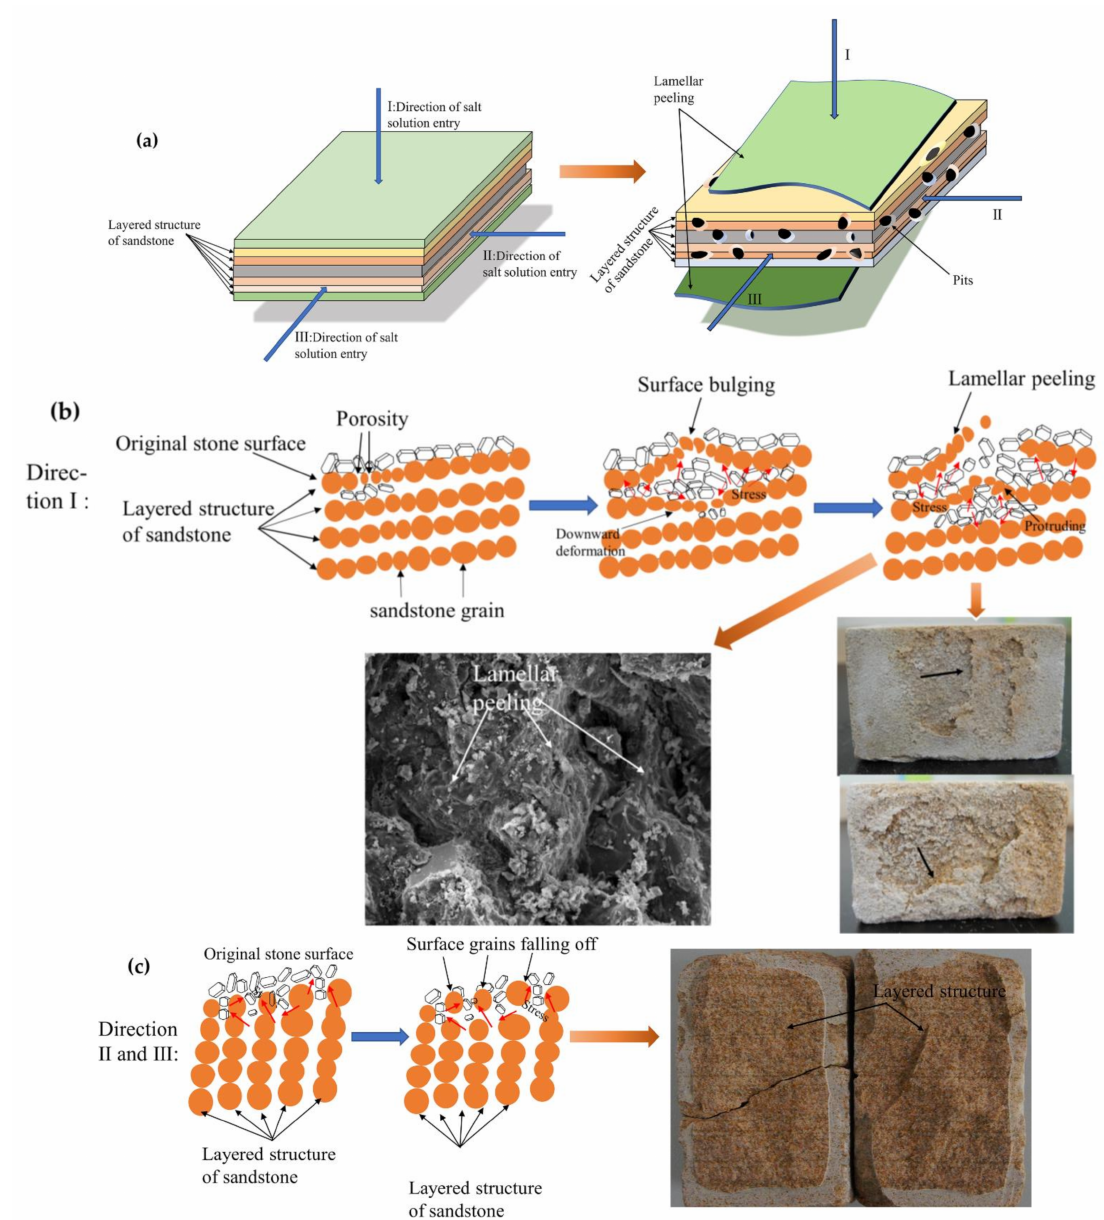
Figure 10. The suggested salt − damage process of the unprotected sandstone in Na 2 SO 4 salt weather- ing cycles. ( a ) The influence of salt solution on sandstone from different directions. ( b ) Salt weathering destroys the layered structure of sandstone to form layered exfoliation. ( c ) Pits and layered